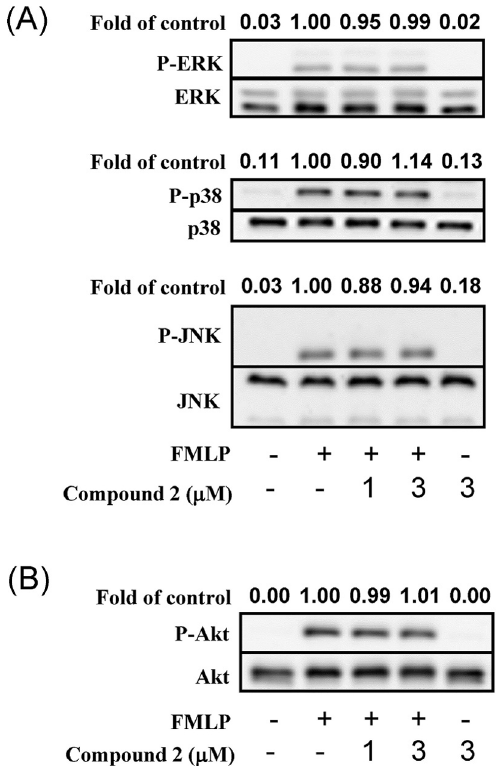
Figure 3. Compound 2 did not alter activation of ERK, p38 MAPK, JNK, and